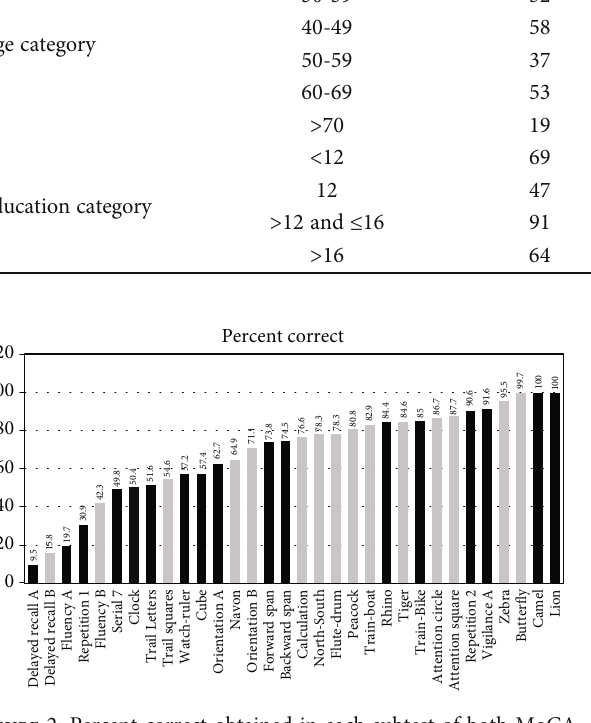
Figure 2: Percent correct obtained in each subtest of both MoCA versions. Table 3: Multivariate regression